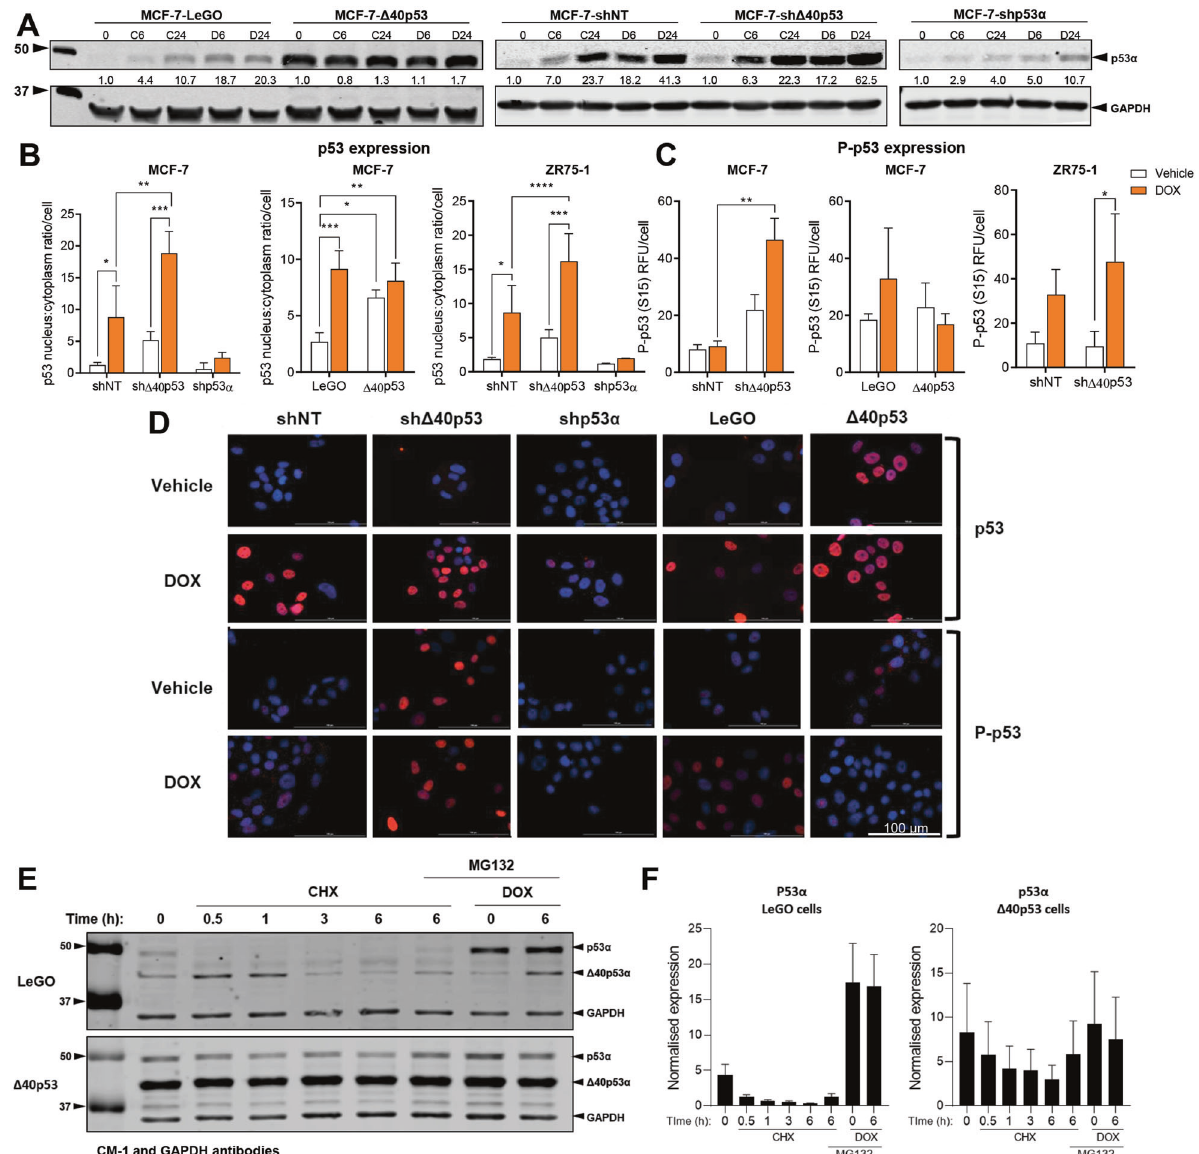
Fig. 4 Δ 40p53 knockdown increases the expression and phosphorylation of p53 following DOX treatment. A Representative immunoblotting analysis from 40 µg of protein extracts showed that p53 protein levels were upregulated after CIS and DOX treatment ( C , D represent CIS and DOX respectively and digits indicate time (hours) after treatment) in the MCF-7-shNT, MCF-7-sh Δ 40p53, MCF-7-shp53 α and MCF-7-LeGO sublines, but not in the MCF-7- Δ 40p53 subline. Fold-change expression is indicated by the digits between p53 and GAPDH western blots. CM-1 (1 μ g/ml) and GAPDH (1 μ g/ml; loading control) primary antibodies were used. Data shown represent three independent experiments. B p53 α nucleus/cytoplasmic ratio and C P-p53 (S15) expression measured by immuno fl uorescence after DOX treatment (24 h) in MCF-7 (-shNT, -sh Δ 40p53, -shp53 α , LeGO and Δ 40p53) and ZR75-1 (-shNT, -sh Δ 40p53, -shp53 α ) sublines. Data shown represent three independent experiments of three technical replicates. D Immuno fl uorescence images of p53 α staining after treatment with vehicle (water) or DOX (24 h) in MCF-7 (-shNT, -sh Δ 40p53, -shp53 α , LeGO and Δ 40p53) sublines. DO-1 (1:100) and P-p53 (S15) (1:400) primary antibodies were used and cell nuclei were stained with DAPI. E Representative immunoblotting analysis of MCF-7-LeGO and MCF-7- Δ 40p53 cell extracts treated with vehicle (water), CHX (40 µg/mL), MG132 (10 µM) and/or DOX (1 µM). CM-1 (1 μ g/ml) and GAPDH (1 μ g/ml) primary antibodies were used. Data shown represent three independent experiments. F Quanti fi cation of p53 α expression of MCF-7-LeGO and MCF-7- Δ 40p53 cell extracts treated with vehicle (water), CHX (40 µg/mL), MG132 (10 µM) and/or DOX (1 µM). Data shown represent three independent experiments. Results are shown as the mean ± SD. Statistical analyses were carried out using two-way ANOVA followed by Sidak ’ s post-test. Results were considered signi fi cant at p < 0.05; * p < 0.05, ** p < 0.01, *** p < 0.001, **** p < PARP1 following 24 h of treatment when compared to shNT and upstream and downstream p53 interactions associated with DOX- sh Δ 40p53 cells (Fig. 8F, Supplementary Fig. 7G, I, M), which may related DDR ( ATM, ATR, CHEK2, HDM2, MAPK1, EP300, TOPOII α , indicate higher activation of DNA repair after treatment. In contrast, TOPOII β , BRCA1, RAD51, RAD52, LIG4, PARP1, APEX1, OGG1 ) was no statistically signi fi cant differences were found in MCF-7- analysed by RT-qPCR in MCF-7 sublines after 6 and 24 h of DOX sh Δ 40p53 cells (Fig. 8F, Supplementary Fig. 7) when compared to treatment and compared to untreated cells (Fig. 8F). p53 α shNT cells. knockdown induced the upregulation of TOPOII α , BRCA1 , and